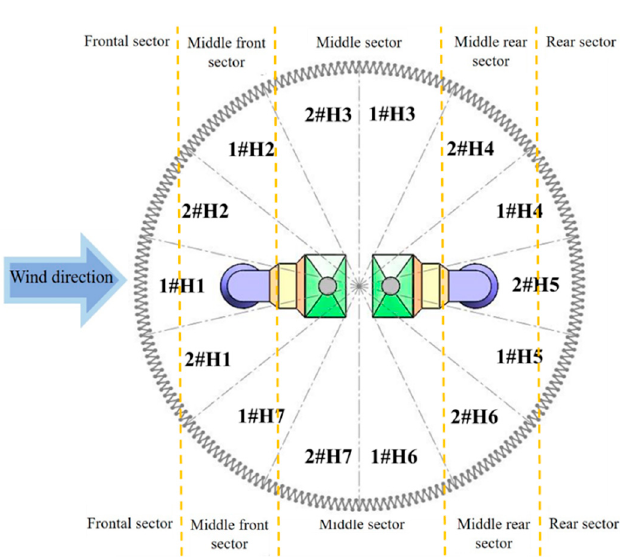
Figure 2. Deployment of air-cooled sectors for each power-generating unit. Table 1. Geometric parameters of ACHE, cooling tower, desulfurizer, GCS, WESP, and flue gas chimney of NDDCS.